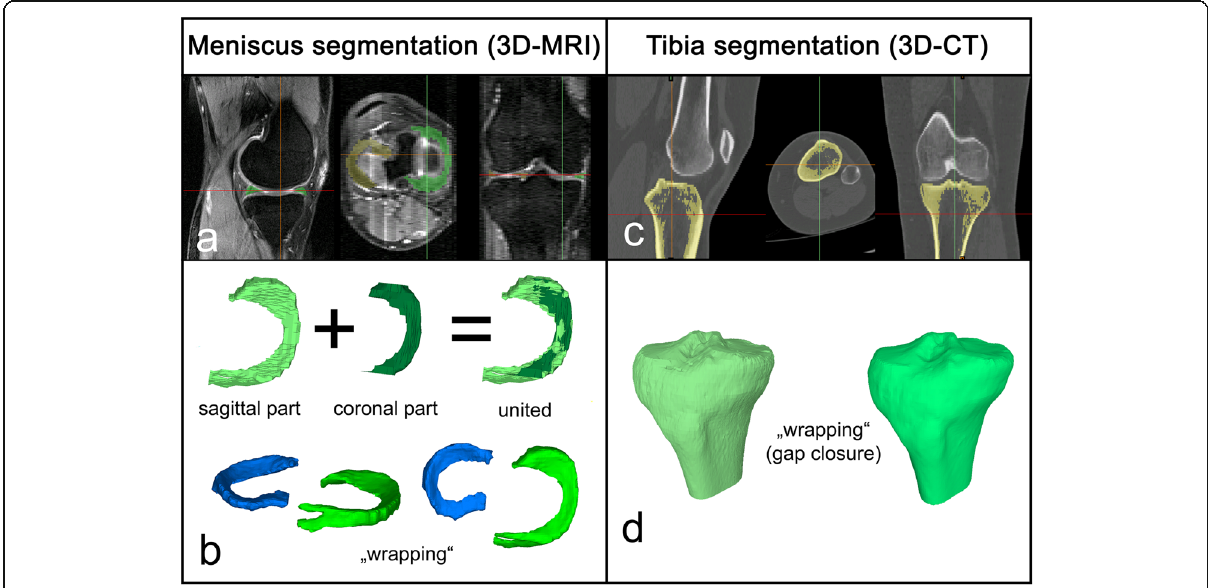
Fig. 1 3D surface models: a . Step 1 (Meniscus): Segmentation was performed in sagittal and coronal slides by manually annotation of all meniscus tissue. b . Step 2 (Meniscus): Three-dimensional sagittal and coronal meniscus parts were merged. If there was a shift due to patients movement during acquisition of the different reconstructions, manual realignement has to be performed first. Wrapping of the meniscus surface models was done by using the functionallity of the 3-matic software. c . Step 1 (Tibia): Segmentation was performed in axial, coronal and sagittal reconstructions by semi- automatic annotation of all tibia bone. d . Step 2 (Tibia): Wrapping of the tibia surface models was done by using the functionallity of